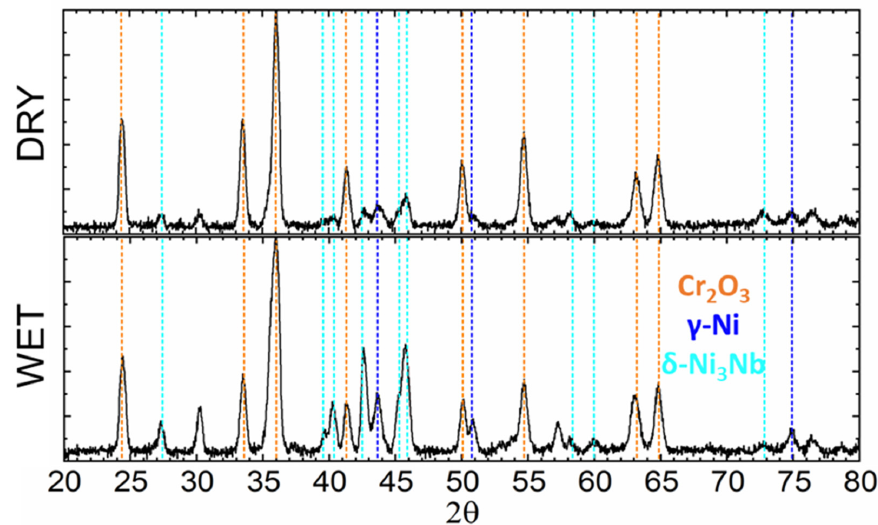
Figure 2. X-ray diffraction patterns obtained for the oxide scale formed on the 718Plus superalloy after oxidation at 850 °C ◦ C for 4000 h in dry and wet air; XRD Bragg–Brentano for 4000 h in dry and wet air; XRD Bragg–Brentano geometry. after oxidation at 850